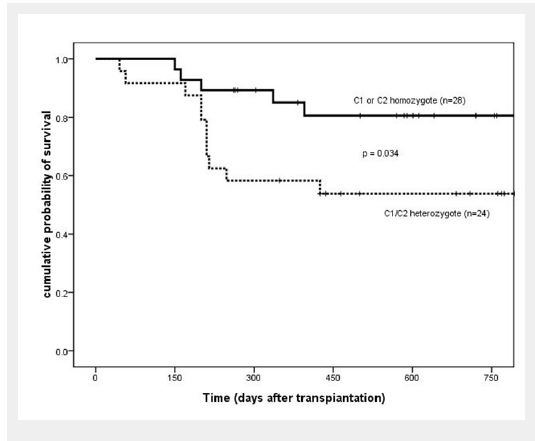
Figure 1 Overall survival of patients based on HLA-Cw ligand groups (C1 or C2 homozygote vs C1/C2 heterozygote). HLA = human leukocyte